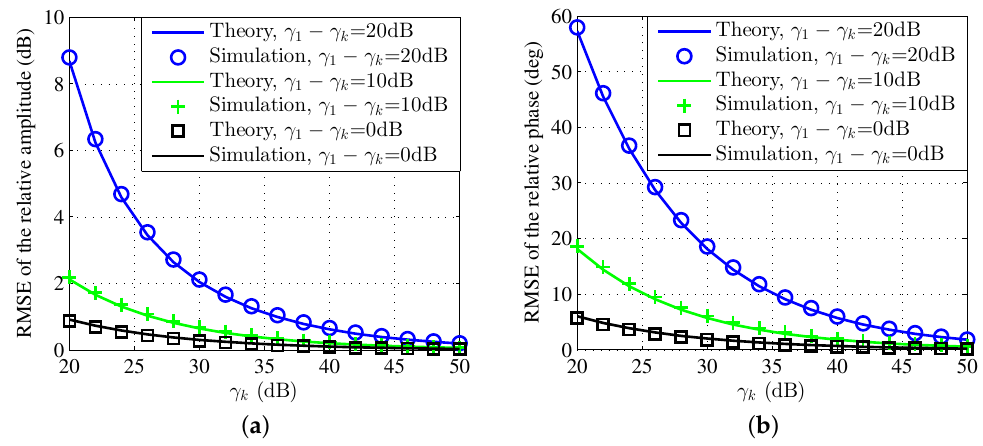
Figure 7. Calibration accuracy with unequal power conditions ( K = 2). ( a ) RMSE of the relative amplitude. ( b ) RMSE of the relative phase.